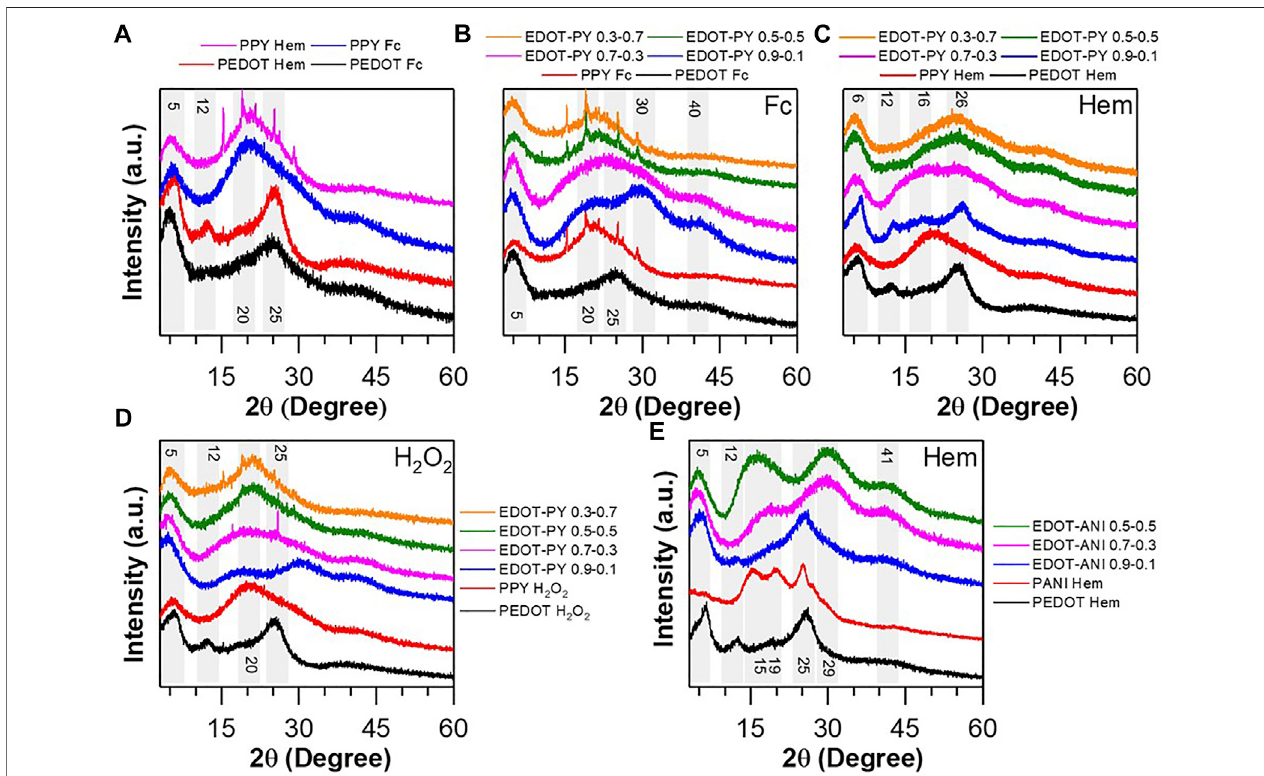
FIGURE 5 | Diffractograms of homopolymers and copolymers: (A) PEDOT and PPY using Hematin and Ferrocene catalysts, (B) EDOT-PY copolymers with Ferrocene catalyst, (C) EDOT-PY copolymers using Hematin catalyst, (D) EDOT-PY copolymers without catalyst, (E) Diffractogram of PEDOT, PANI and EDOT-ANI copolymers with different molar ratios doped with TSA and using Hematin as